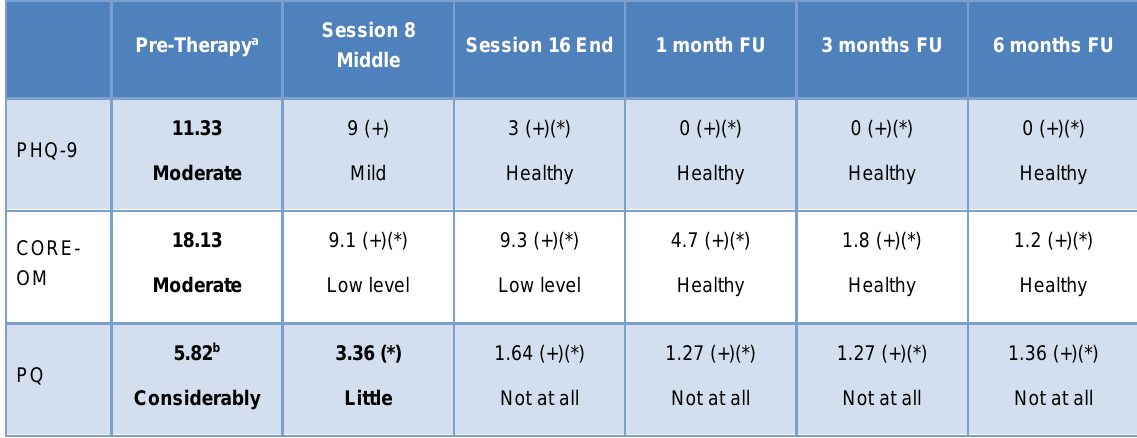
Table 1. The initial depressive score (PHQ-9, 11.33) indicated a moderate level of depression. The global